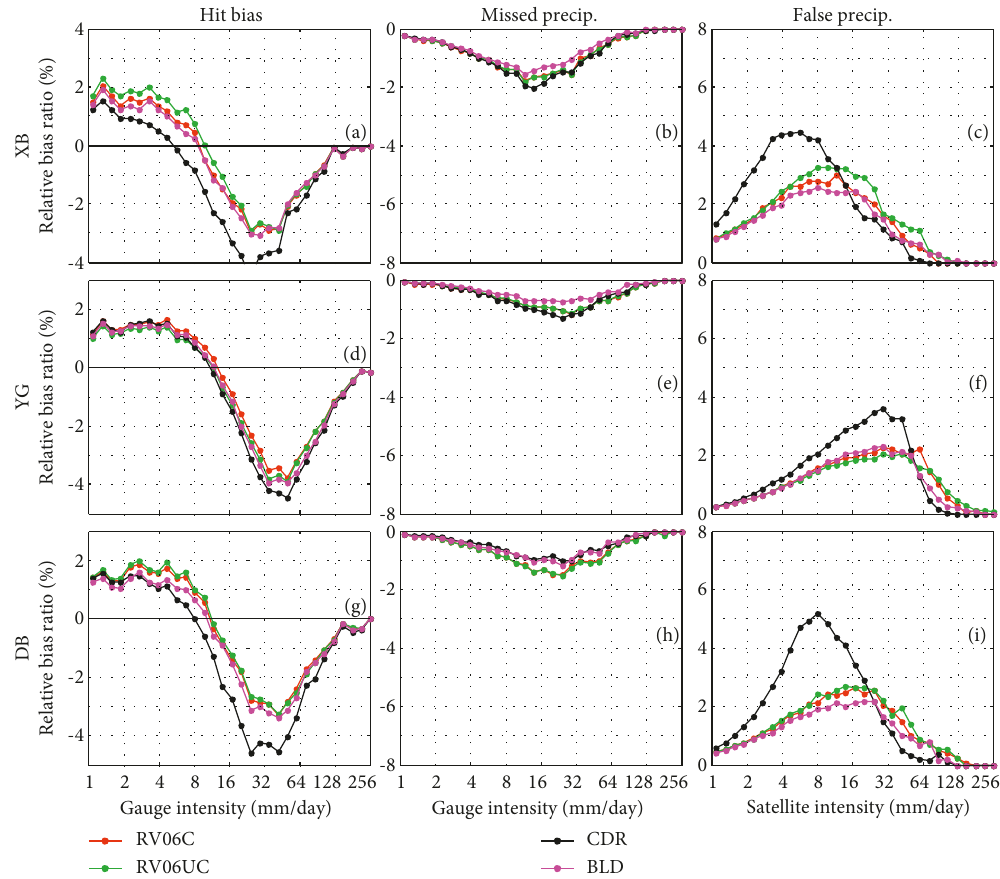
Figure 19: Same as Figure 18 except for the XB, YG, and DB